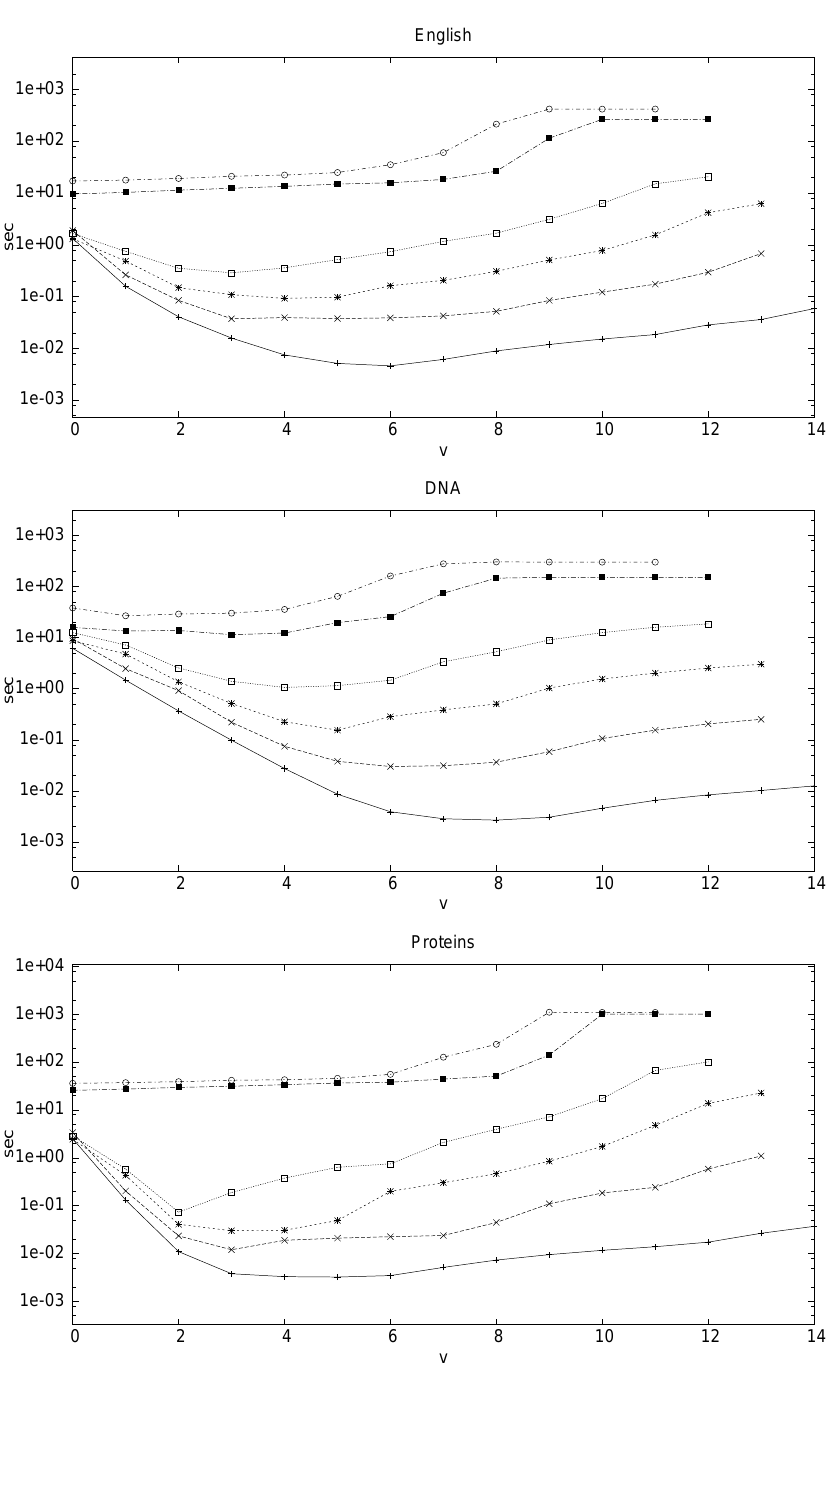
Figure 9. Average user time, in seconds, that the ILZI takes to find occurrences of patterns of size 30 with k errors, using different v